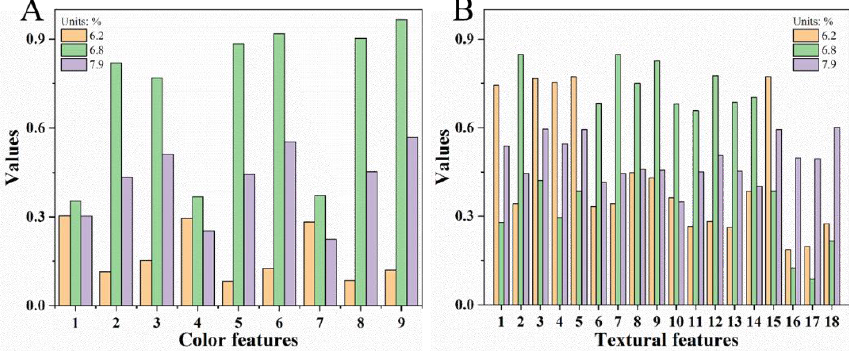
Figure 3. Color ( A ) and textural ( B ) features of strawberries with different SSCs. Table 3. Prediction results of SSC, pH, and VC of 120 strawberries using spectral, color, and textural